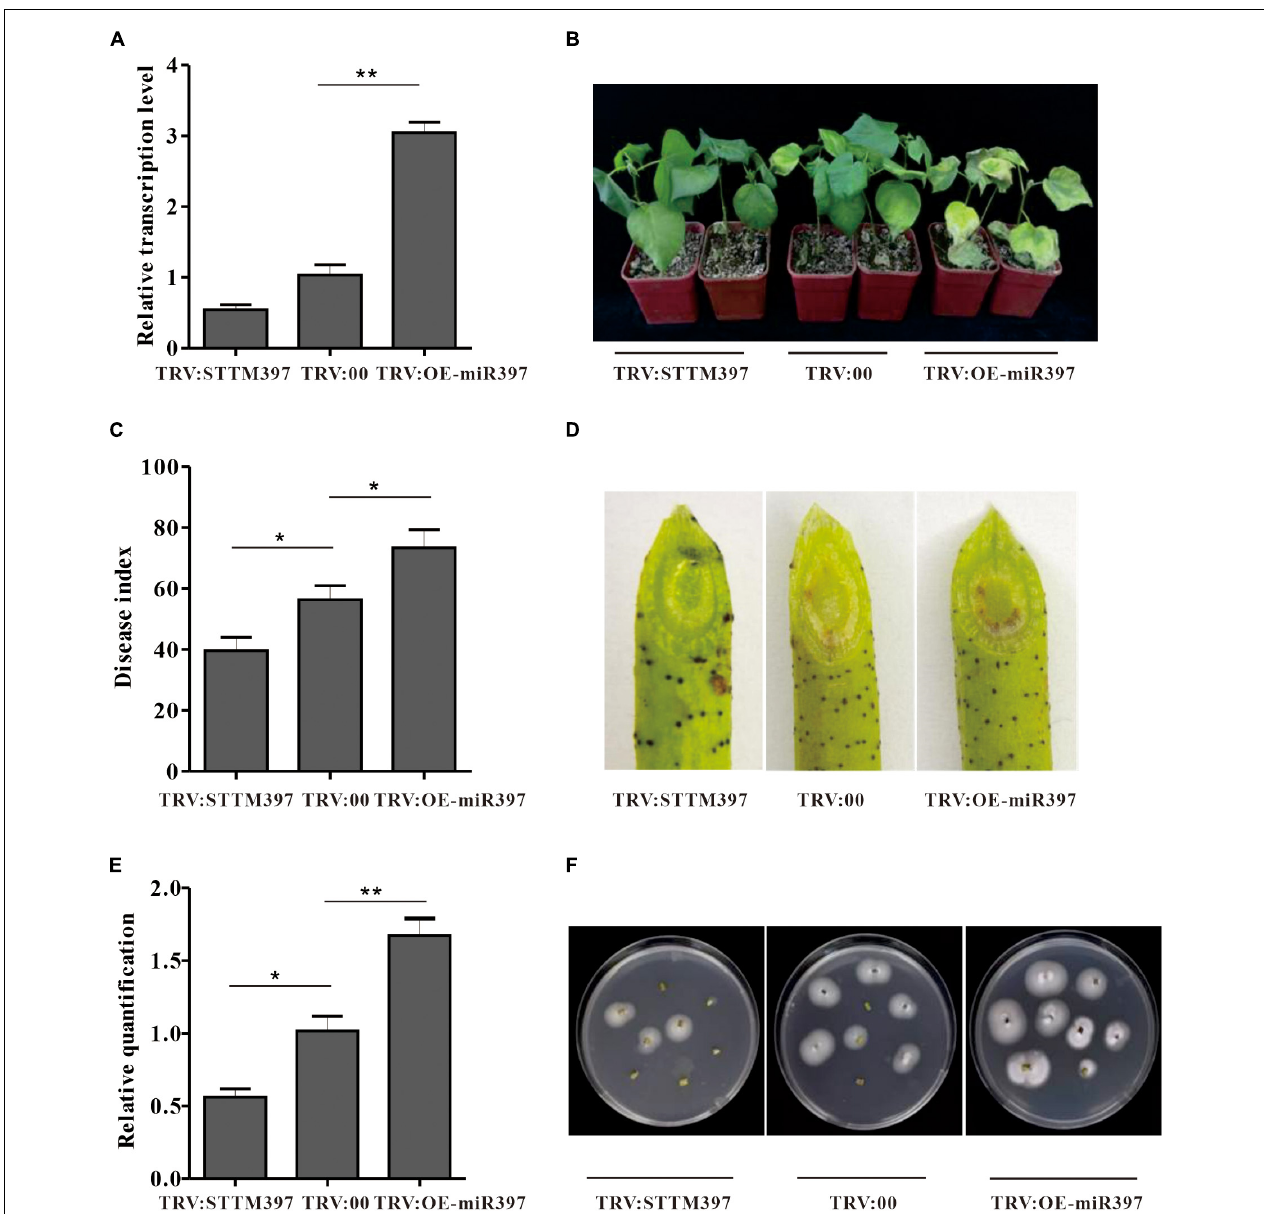
FIGURE 3 | The miR397 negatively regulated plant resistance against V. dahliae . (A) Relative expression levels of ghr-miR397 in the TRV:STTM397 and TRV:OE-miR397 plants compared to the TRV:00 plants. The value of ghr-miR397 abundance at the TRV:00 plants were arbitrarily designated as ‘1.’ (B)